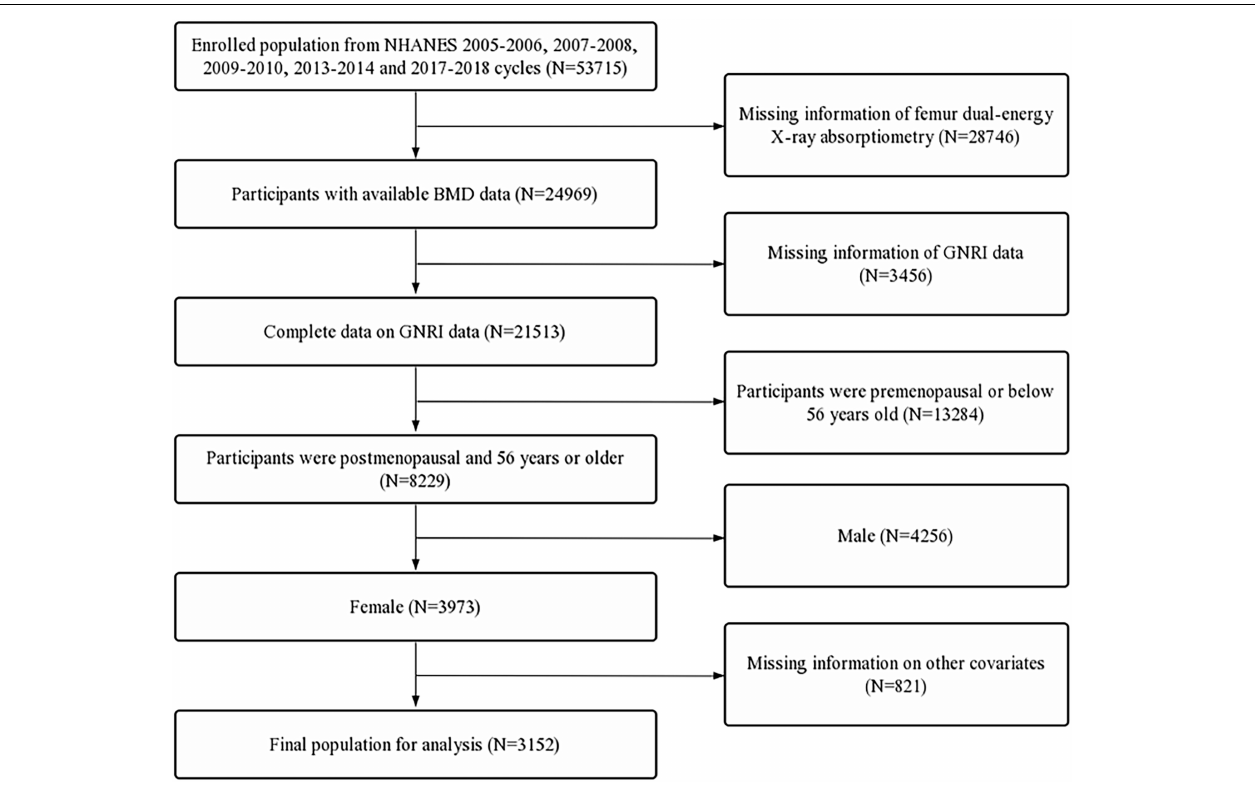
FIGURE 1 | Flow diagram of the inclusion criteria and exclusion criteria. NHANES, National Health and Nutrition Examination Survey; GNRI, geriatric nutritional risk index; BMD, bone mineral